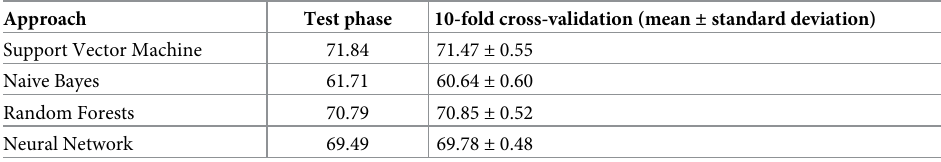
Table 4. Accuracy of the models in the test phase and the 10-fold